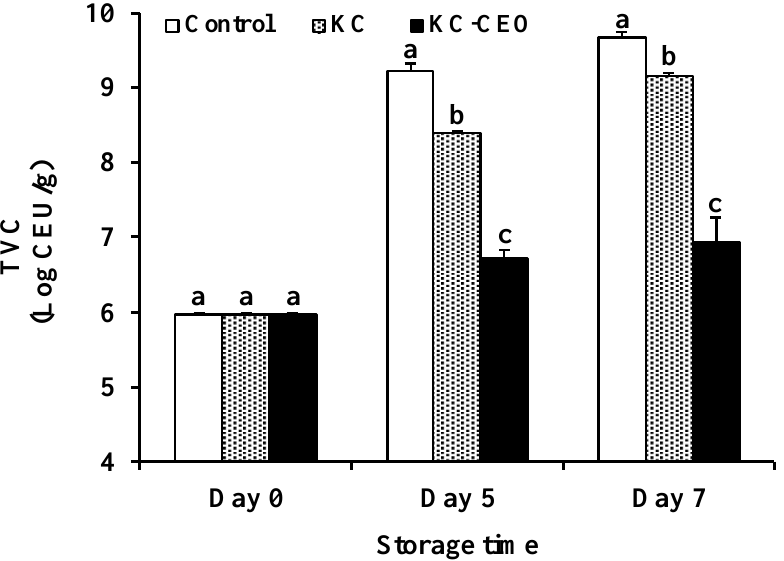
Figure 1. Impact of KC-based coatings on TVC of pork meat during refrigerated storage (4 °C). KC, kappa-carrageenan; CEO, cinnamon essential oil; TVC, total viable count. Different letters for data points on each day represent significant differences ( p < 0.05).